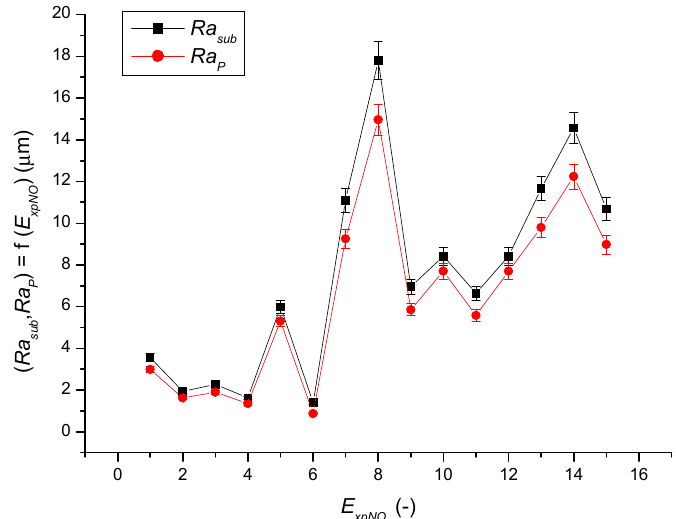
Figure 11. Roughness R a of EN 100 60 substrate and spraying NiCrBSi alloy according to R mp for E xpNO .